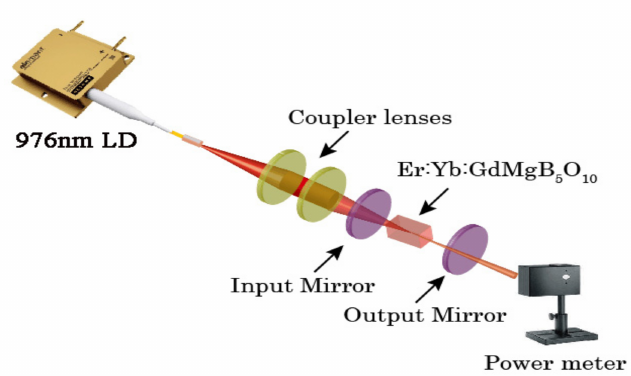
Figure 2. Experimental setup of LD-end-pumped Er:Yb:GMB